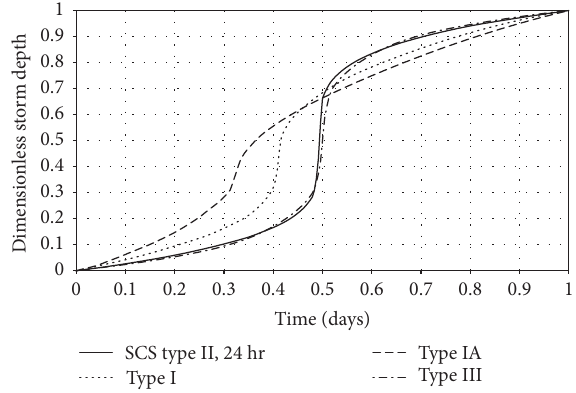
Figure 1: SCS 24-hour hypothetical storm